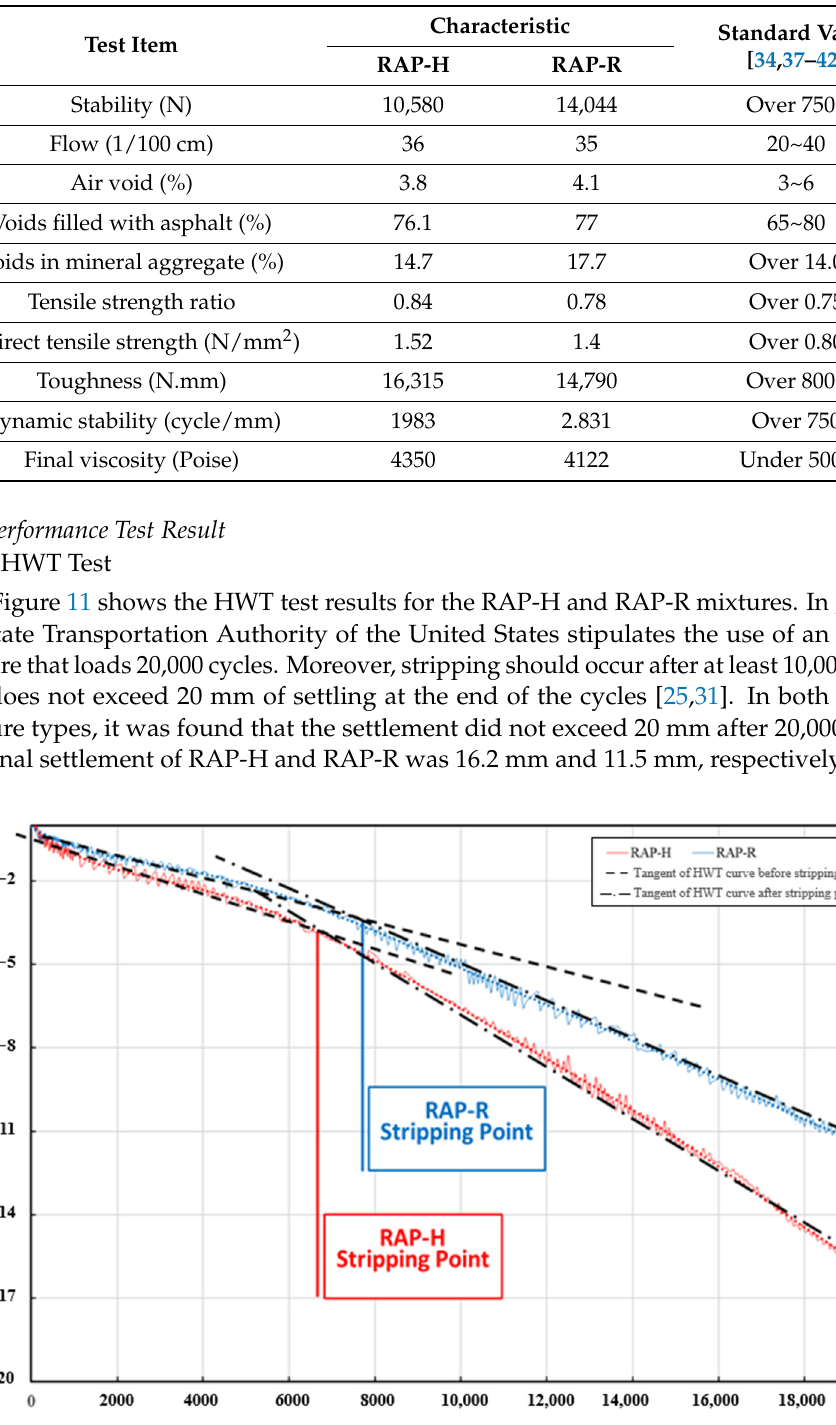
Table 9. The property test result of RAP-H and RAP-R.